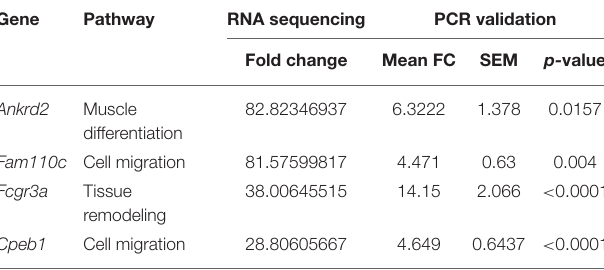
TABLE 1 | Validation of RNA sequencing.